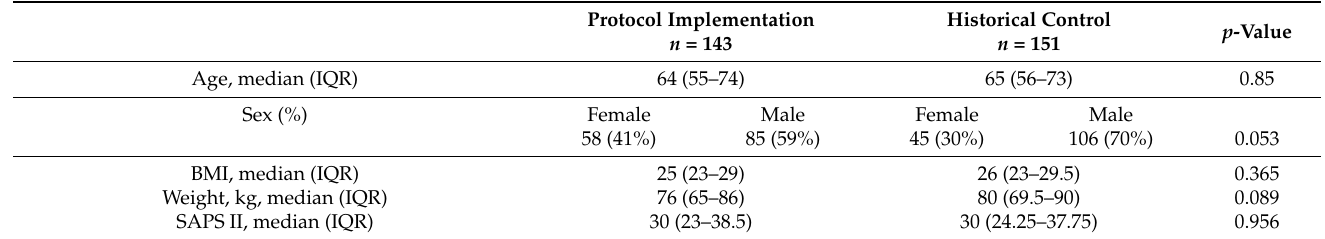
Table 1. Baseline